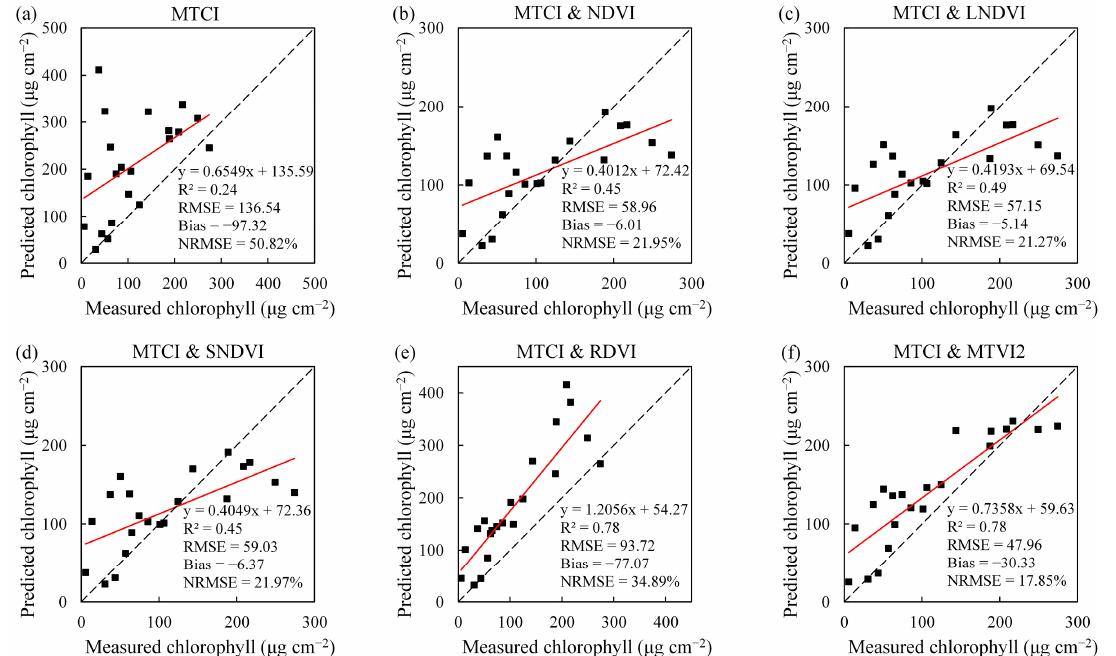
Figure 11. Accuracy of CCC retrieval for soybean crops using RFR and MERIS imagery: ( b ) MTCI and NDVI; ( c ) MTCI and LNDVI; ( d ) MTCI and SNDVI; ( e ) MTCI and RDVI; ( f ) MTCI and MTVI2. The performance of a single MTCI in a linear regression model is displayed in ( a ) for comparison.